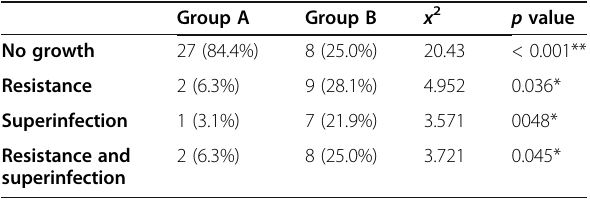
Table 8 Comparison between study groups as regards organism clearance after treatment